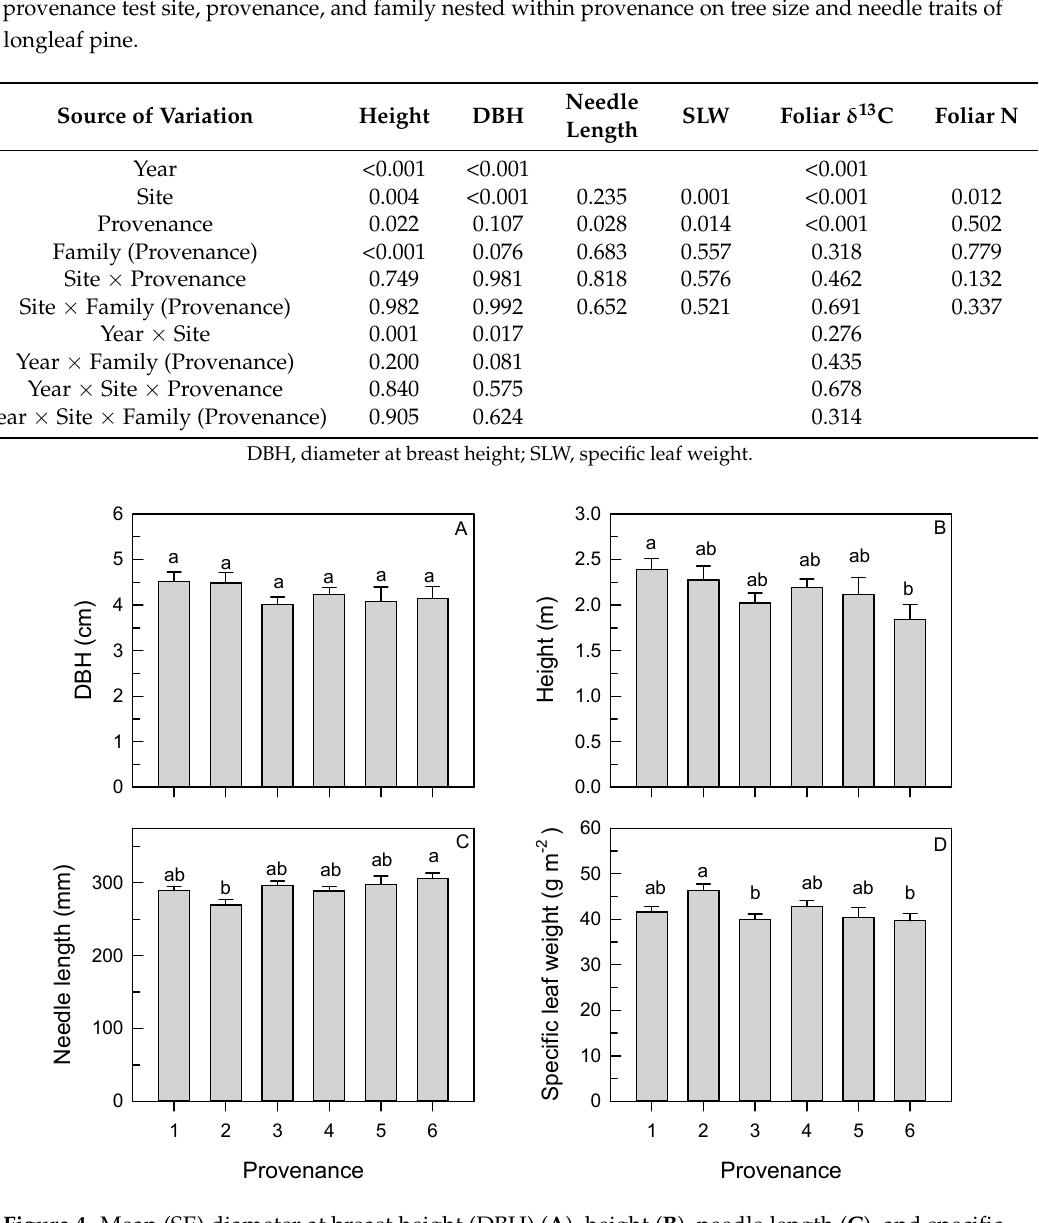
Figure 4. Mean (SE) diameter at breast height (DBH) ( A ), height ( B ), needle length ( C ), and specific leaf weight ( D ) of longleaf pine trees from different provenances. Different letters indicate significant differences among provenances. Means reflect data pooled across two provenance test sites and 2 years (where